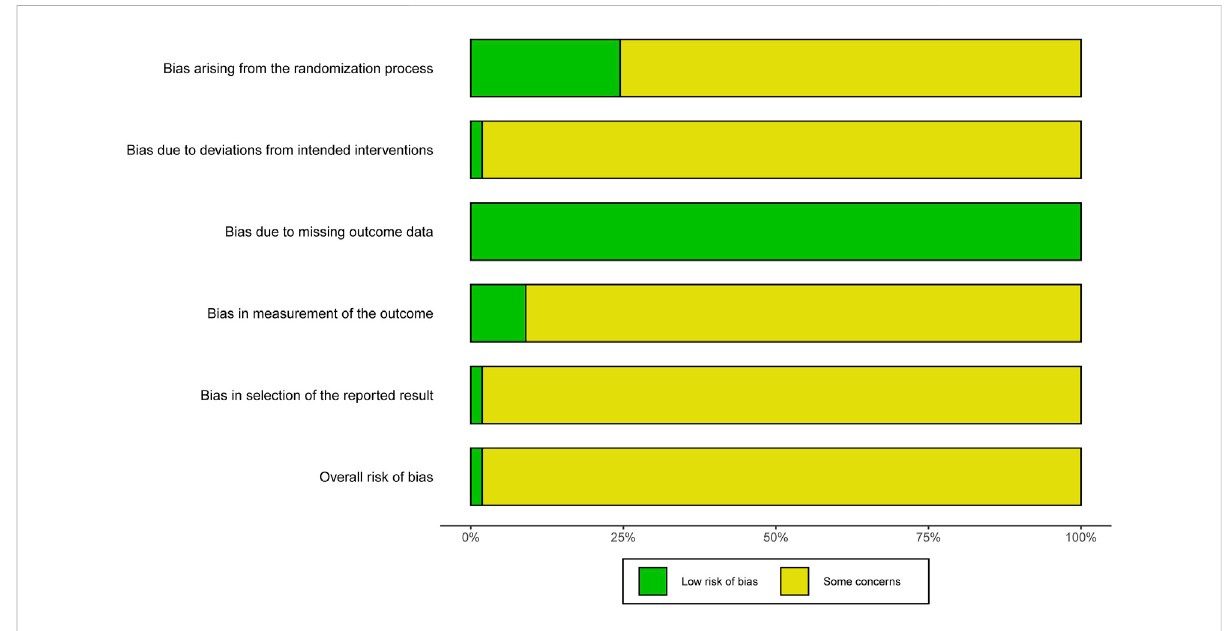
FIGURE 3 Risk of bias